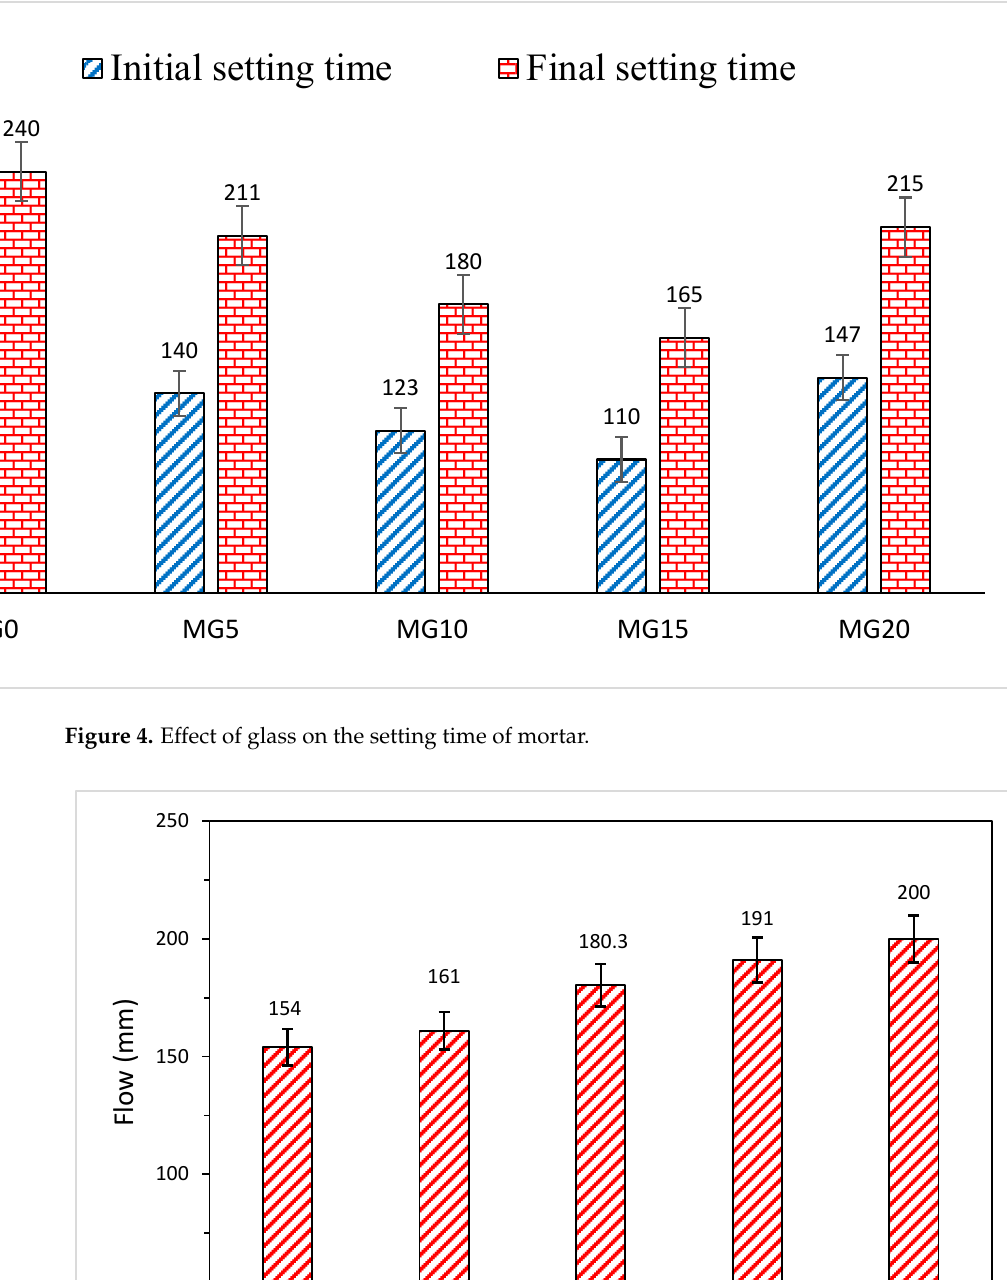
Figure 4. Effect of glass on the setting time of mortar.